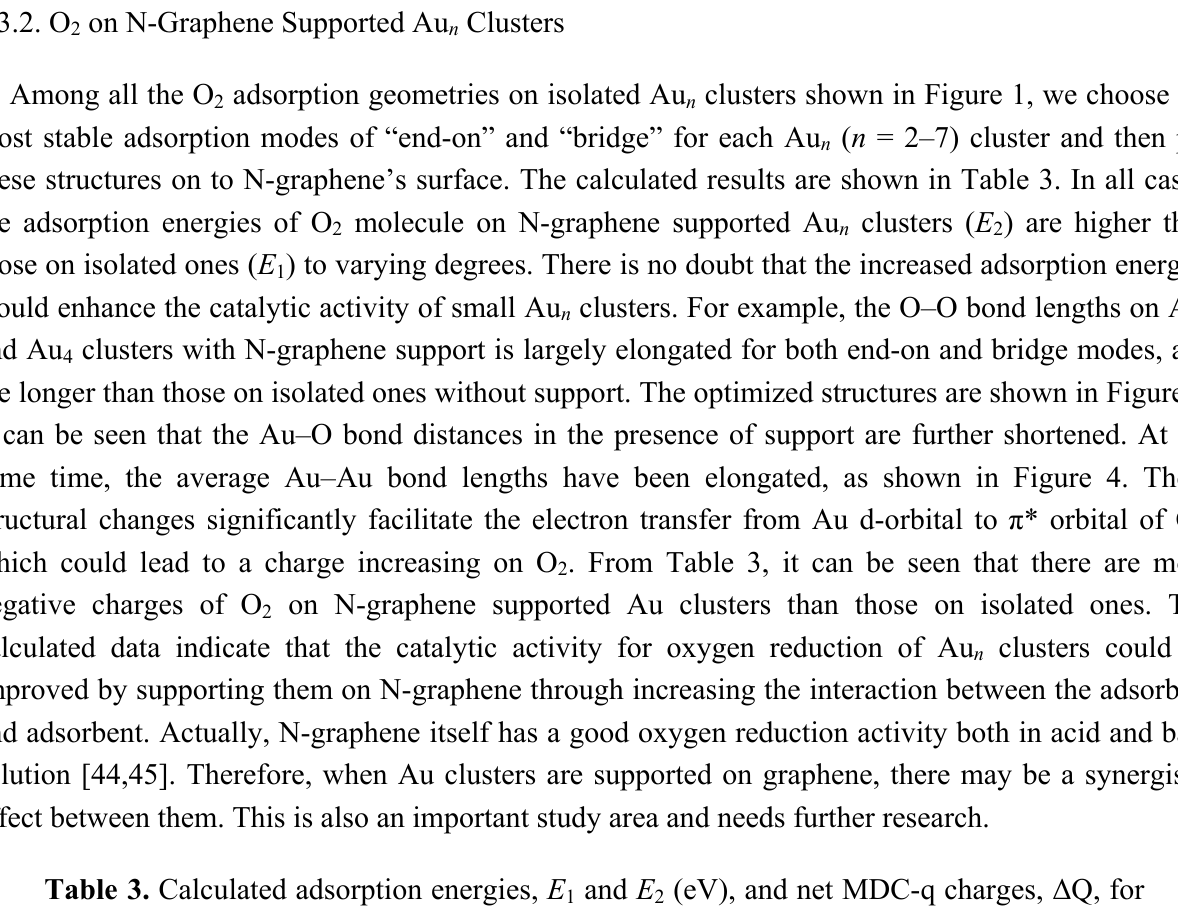
and E (eV), and net MDC-q charges, Δ Q, for 1 2